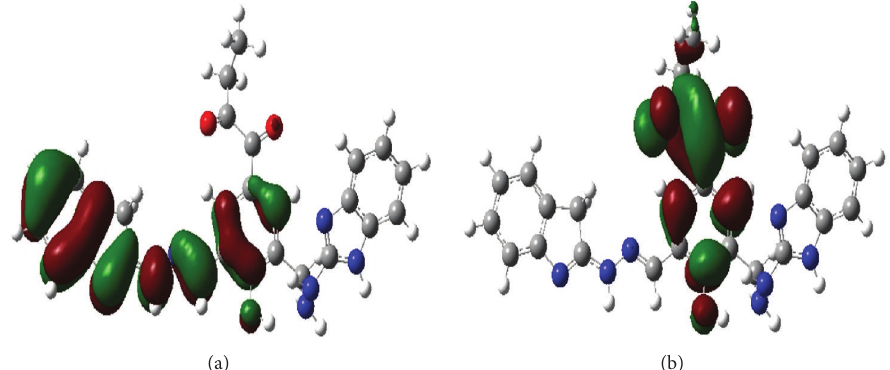
Figure 10: Molecular orbital distribution plots of (a) HOMO and (b) LUMO states in the ground state of Ligand 19 at M06/6-31g(d) level in gas